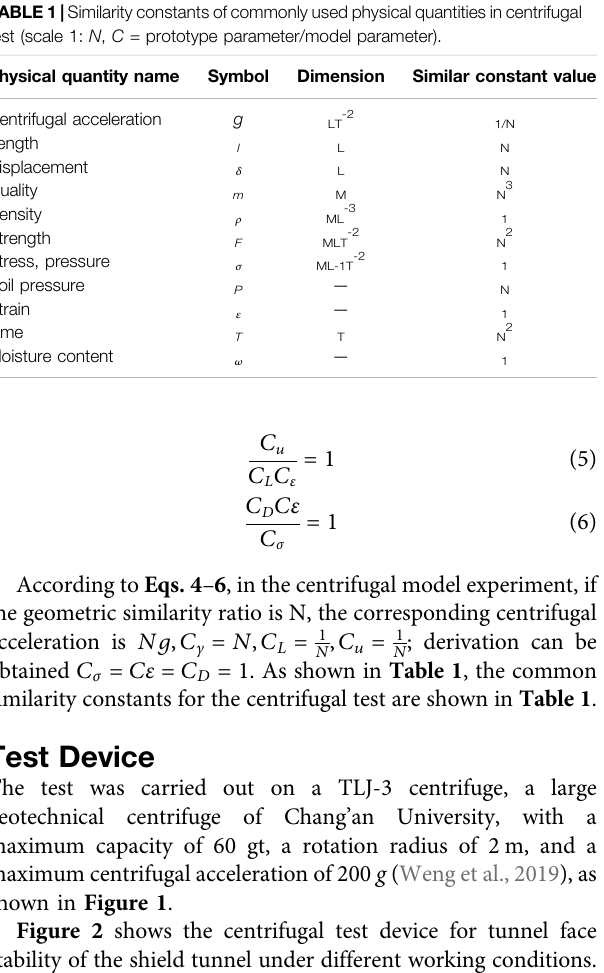
Frontiers in Earth Science |